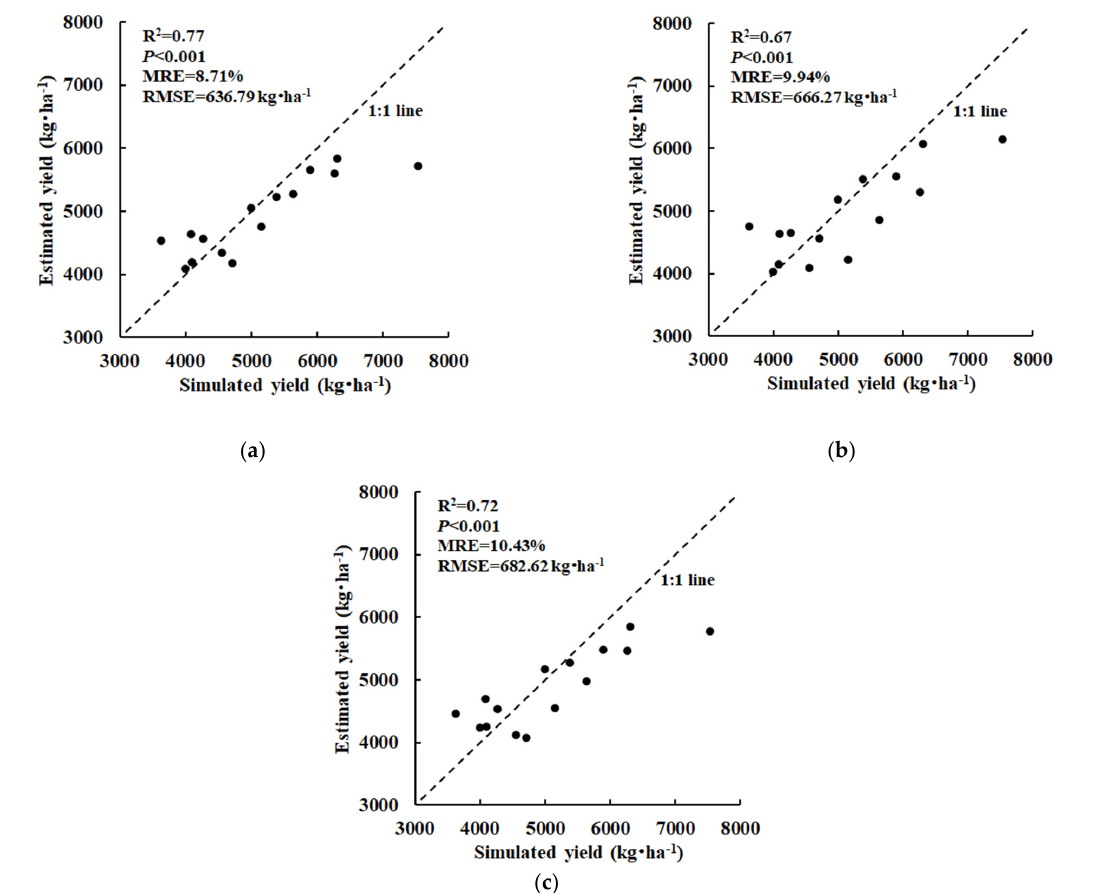
Figure 9. The R 2 , MRE and RMSE for the relationship between the simulated and estimated yields for the (a) LSTM, (b) 1-D CNN and (c) RF models.